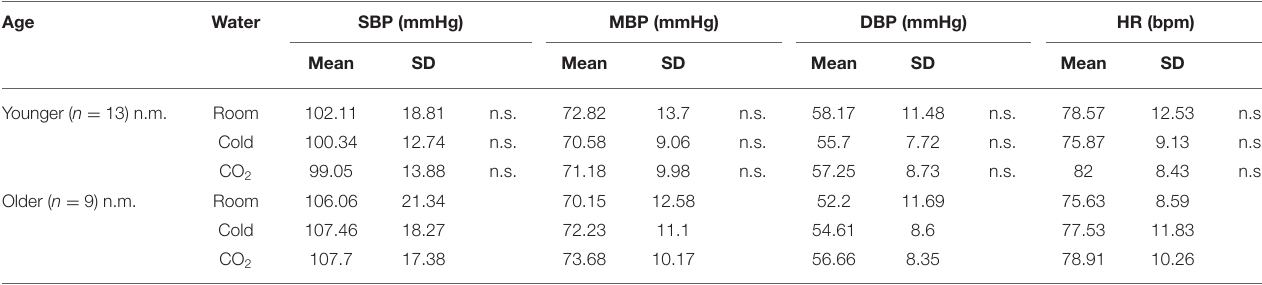
TABLE 1 | Blood pressure and heart rate at control period by water type in experiment 1. Age Water